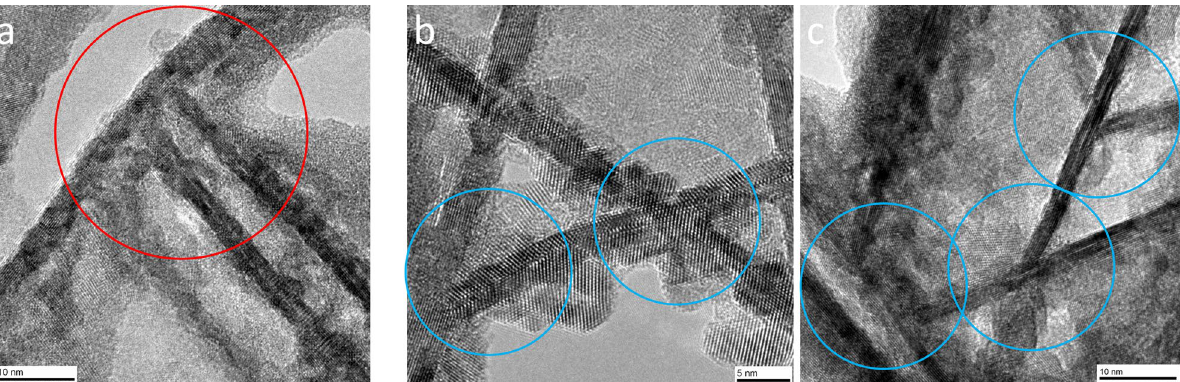
(Fig. 6b, left). The two bold lines correspond to the {101} crystal planes from the direction of B = < 1 − 1 − 1> of